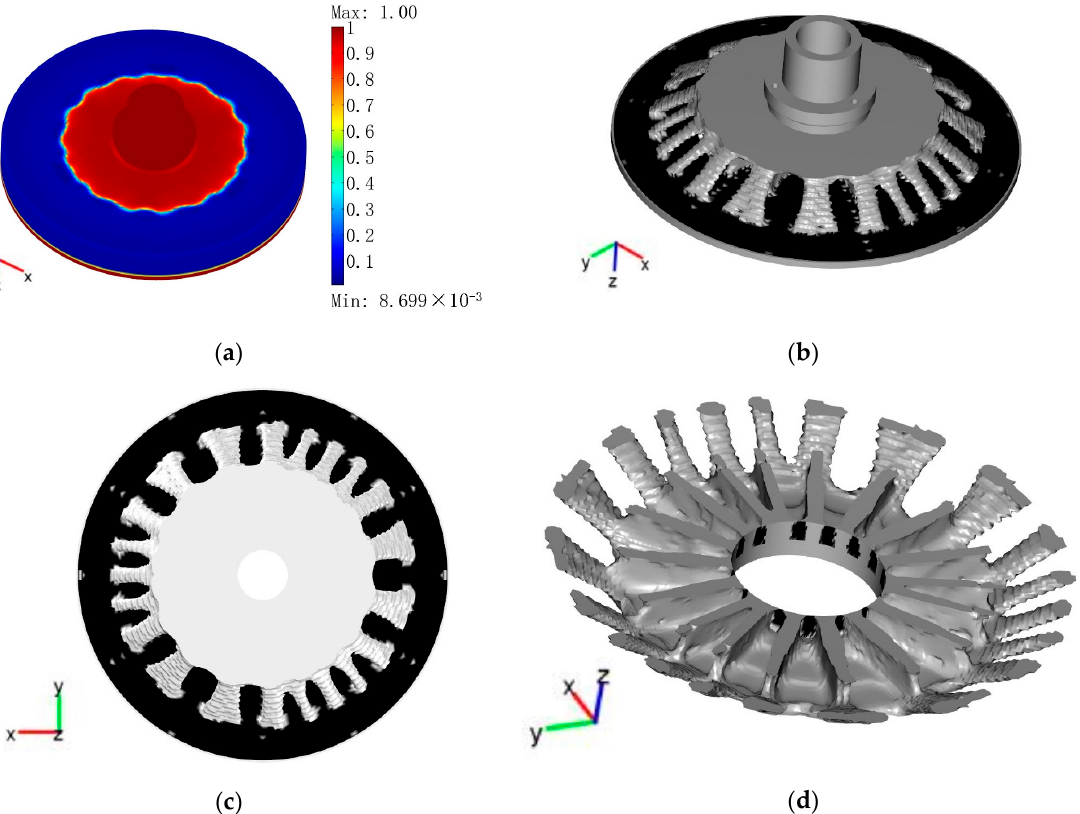
Figure 10. Optimization results in the vertical condition of the optical axis. ( a ) The density of the mirror; ( b ) Mirror structure with a density threshold of 0.6; ( c ) Bottom view of the optimized mirror; ( d ) Optimal structure of the design domain.